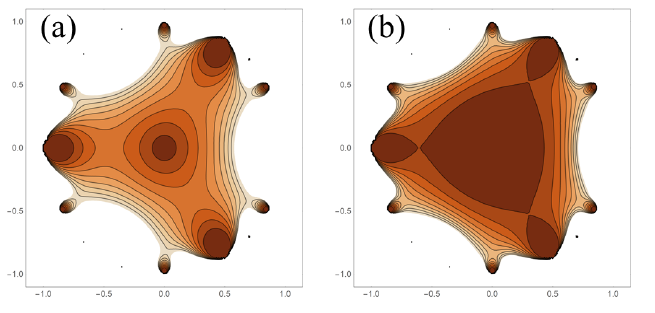
( k ) ( 3 ) ( z ) and for k = 3, i.e., 3 R 10 10